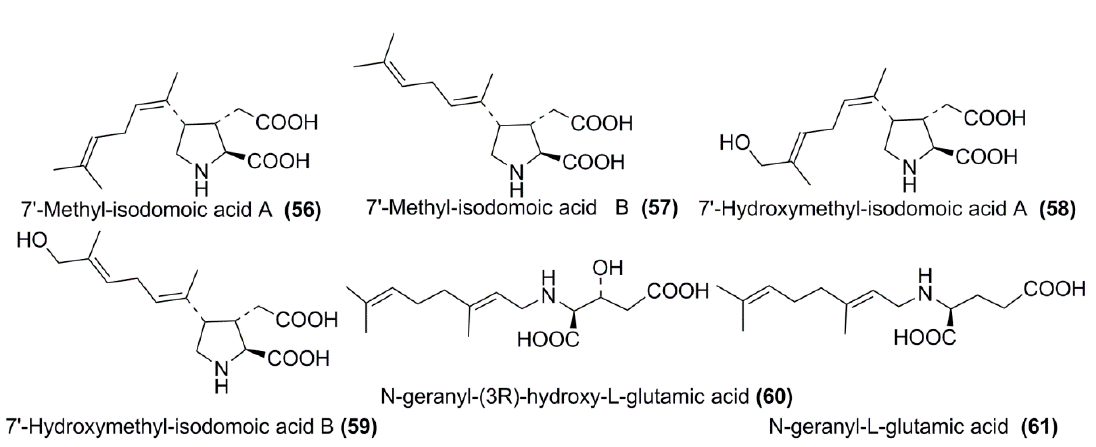
Figure 4. Dainic acids ( 56 – 59 ) and related metabolites ( 60,61 ) from C. armata.